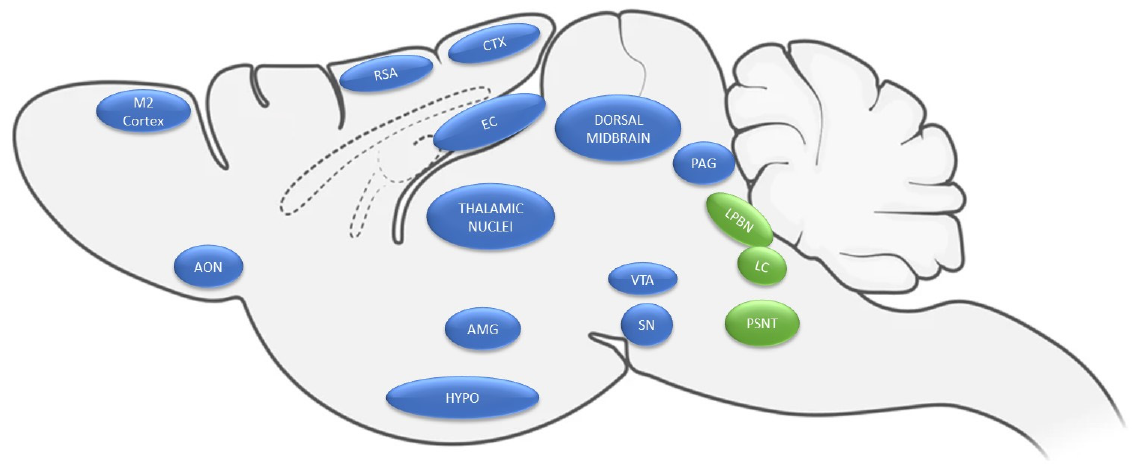
Figure 1. Schematic representation of NPS precursor and NPSR1 transcript distribution in the rat brain. Green circles (PSNT: principal sensory trigeminal nucleus, LPBN: lateral parabrachial nucleus and LC: peri-locus coeruleus) represent areas of NPS precursor mRNA expression, while blue circles (M2cortex: secondary motor cortex, AON: anterior olfactory nucleus, RSA: agranular retrosplenial cortex, CTX: cortex, EC: entorhinal cortex, thalamic nuclei, AMG: amygdala, HYPO: hypothalamus, dorsal midbrain; VTA: ventral tegmental area; SNC: substantia nigra, PAG: periaqueductal gray area) depict brain regions with NPSR1 transcript expression.